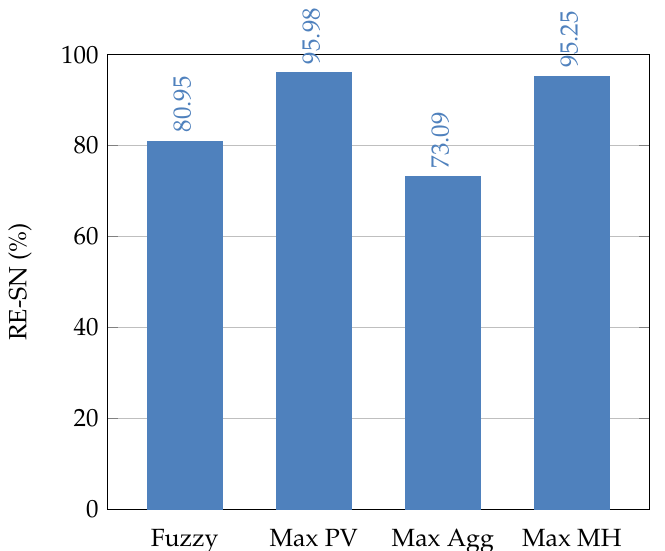
Figure 6. Renewable energy used within a Smart Neighborhood (RE-SN) for the different decision maker strategies.